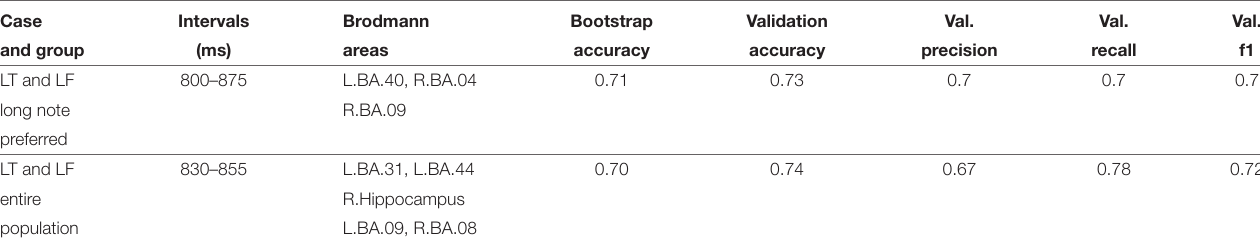
TABLE 2 | Models for classification of message credibility evaluations of long notes without prior knowledge (LT and LF cases) for participants who preferred long notes and for the entire population.